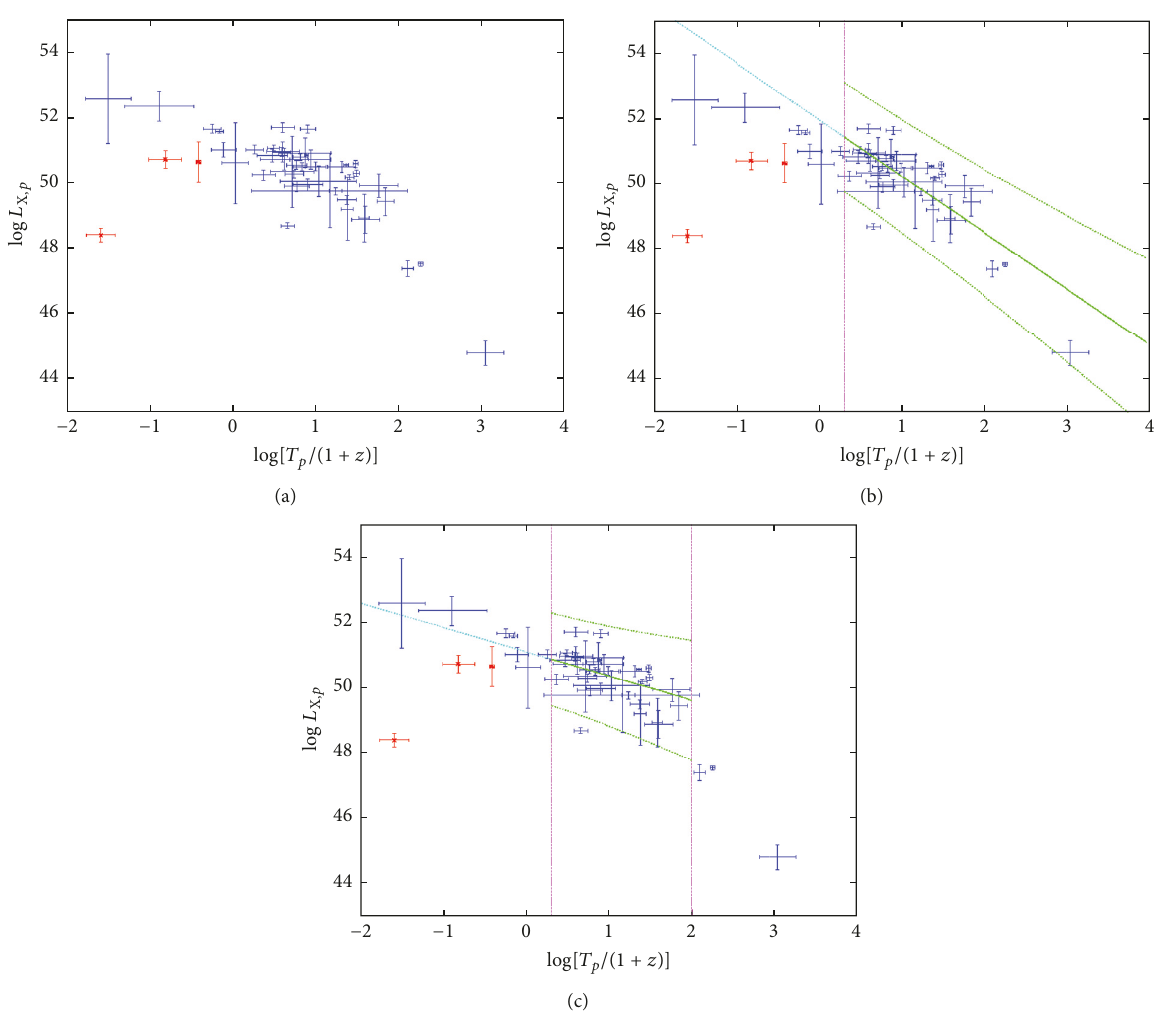
Figure 14: (a) log 𝐿 𝑋,𝑝 (in ergs −1 ) versus log 𝑇 ∗ 𝑝 (ins) for the whole sample of 47GRBs. The red dots represent SGRBs (i.e., 𝑇 90 < 2 s). (Figure after Qi and Lu [249]; see Figure 1 therein. @ AAS. Reproduced with permission.) (b) Best fit of the log 𝐿 𝑋,𝑝 (in erg s −1 ) versus log 𝑇 ∗ 𝑝 (in s) relation following equation (64) and the corresponding 2𝜎 confidence region. Only GRBs with 𝑇 ∗ 𝑝 > 2 s are included in the fit. (Figure after Qi and Lu [249]; see Figure 2 therein. @ AAS. Reproduced with permission.) (c) Best fit of the log 𝐿 𝑋,𝑝 (in ergs −1 ) versus log 𝑇 ∗ 𝑝 (in s) relation following equation (64) and the corresponding 2𝜎 confidence region. In this case only the 34 GRBs with 2 s < 𝑇 ∗ 𝑝 < 100 s are included in the fit. (Figure after Qi and Lu [249]; see Figure 3 therein. @ AAS. Reproduced with